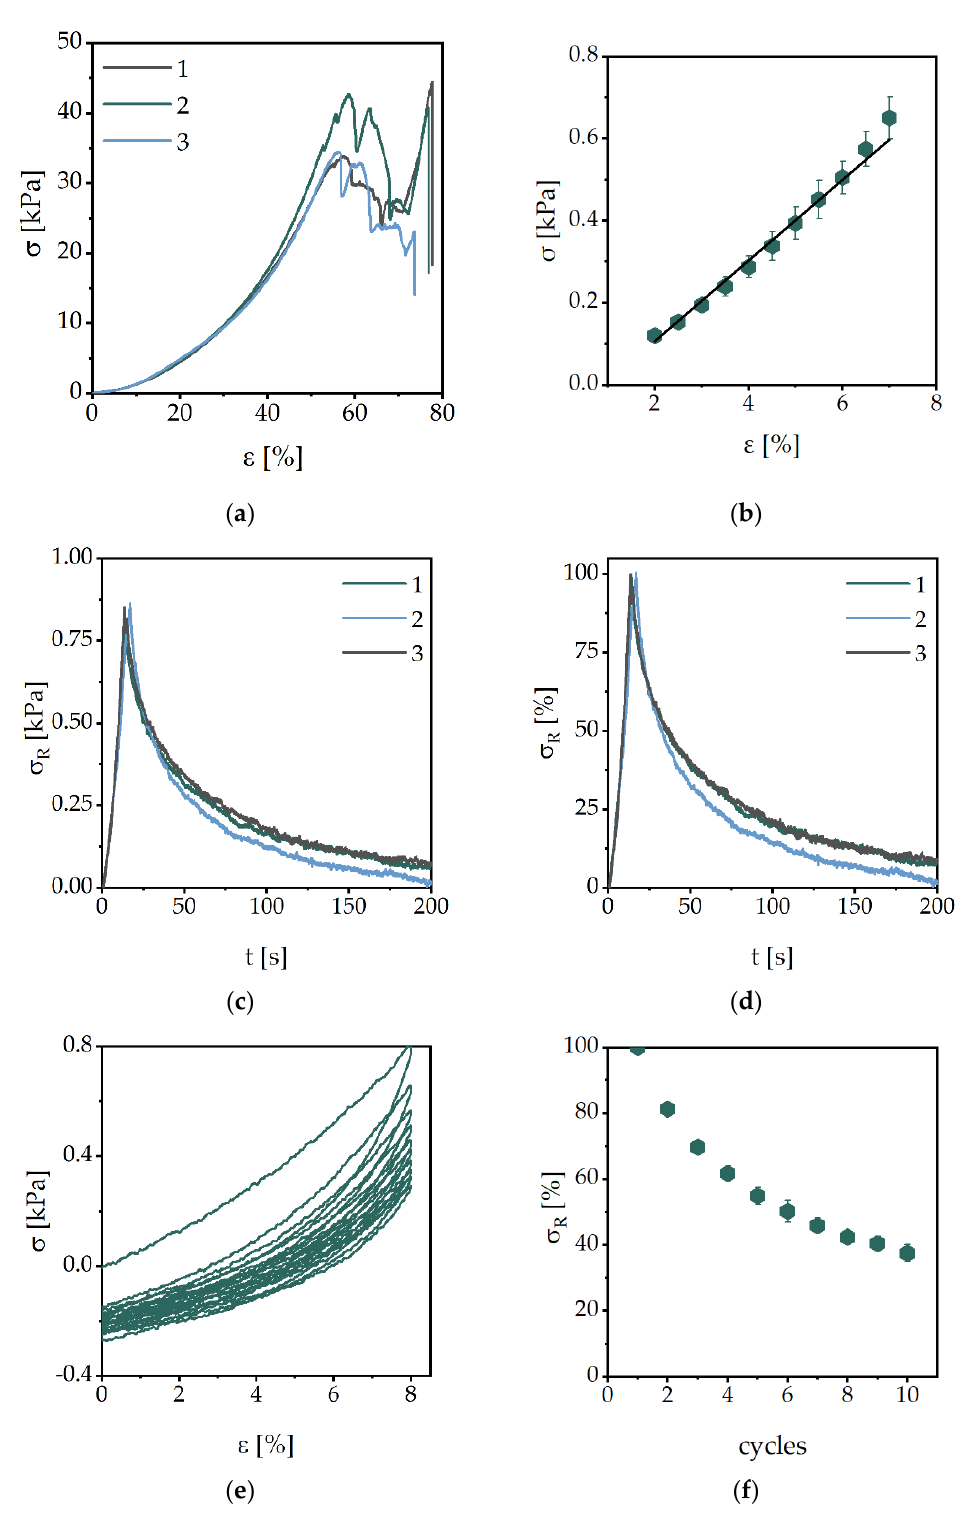
Figure 3. Mechanical characterization of MASO 3 (2 mol/L) with BAP (2 mol%) as a crosslinker: ( a ) Figure 6. Characterization of ChondroFiller ® liquid with ( a ) the stress-strain curves, ( b ) the linear technical stress-strain curves of three single measurements with the swollen hydrogel until break- Figure 6. Characterization of ChondroFiller ® liquid with ( a ) the stress-strain curves, ( b ) the linear interpolation of the data from ɛ = 2 − 7% to determine the compressive modulus, ( c ) the stress-relax- age and ( b ) linear interpolation of the data from ɛ = 2 − 7% to determine the compressive modulus. = 2 − 7% to determine the compressive modulus, ( c ) the stress- interpolation of the data from ation profile to the total stress, ( d ) the stress-relaxation experiment to the residual stress, ( e ) on of relaxation profile to the total stress, ( d ) the stress-relaxation experiment to the residual stress, ( e ) on the cyclic compression loading experiments and ( f ) the normalized residual stress of each cyclic of the cyclic compression loading experiments and ( f ) the normalized residual stress of each cyclic loading experiment. loading